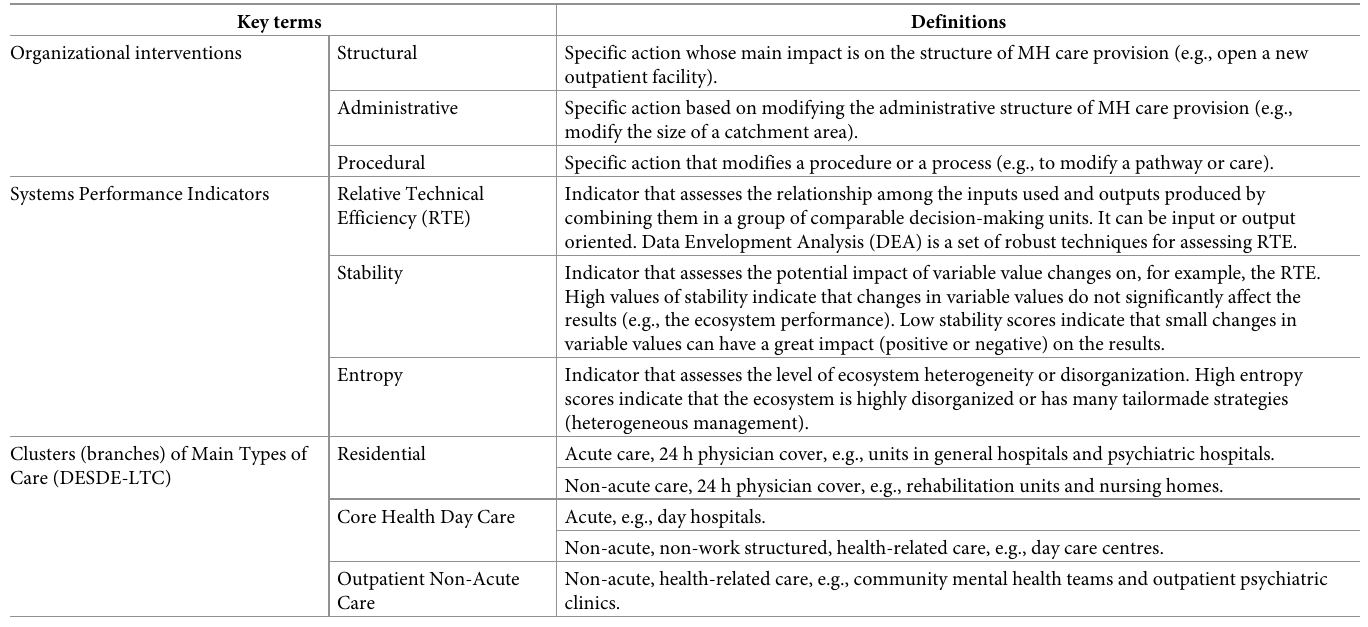
Table 2. Glossary of key terms and indicators for assessing ecosystem